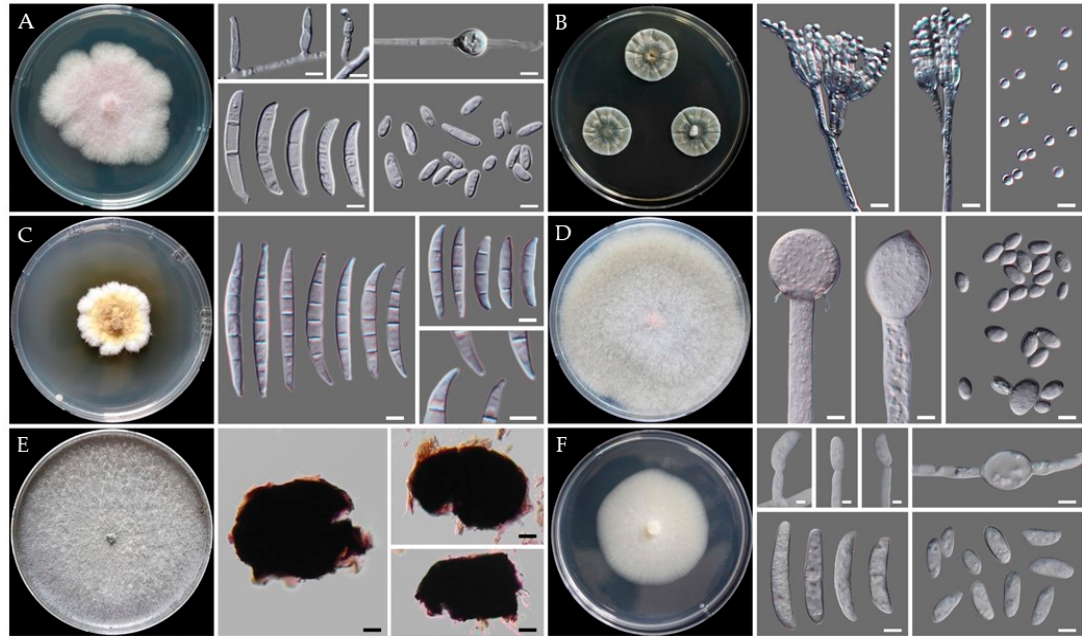
Figure 7. Morphological characteristics of representative isolates cultured on PDA or CYA for 7 days at 25°C. ( A ) F. oxysporum CMML21–2, colony on PDA, monophialides, chlamydospores, macro, and microconidia; ( B ) P. citrinum CMML21–5, colony on CYA, conidiophores and conidia; ( C ) F. ipomoeae CMML21–8, colony on PDA, macroconidia, and typical structures of conidial ends; ( D ) Mu. variicolumellatus CMML21–12, colony on PDA, sporangium, and multi sized spores; ( E ) M. phaseolina CMML21–15, colony on PDA with sclerotia; and ( F ) F. solani CMML21–17, a colony on PDA, monophialides, intercalary chlamydospores, macro and microconidia. Scale bars, A – D , F = 5 μ m and E = 10 μ m.